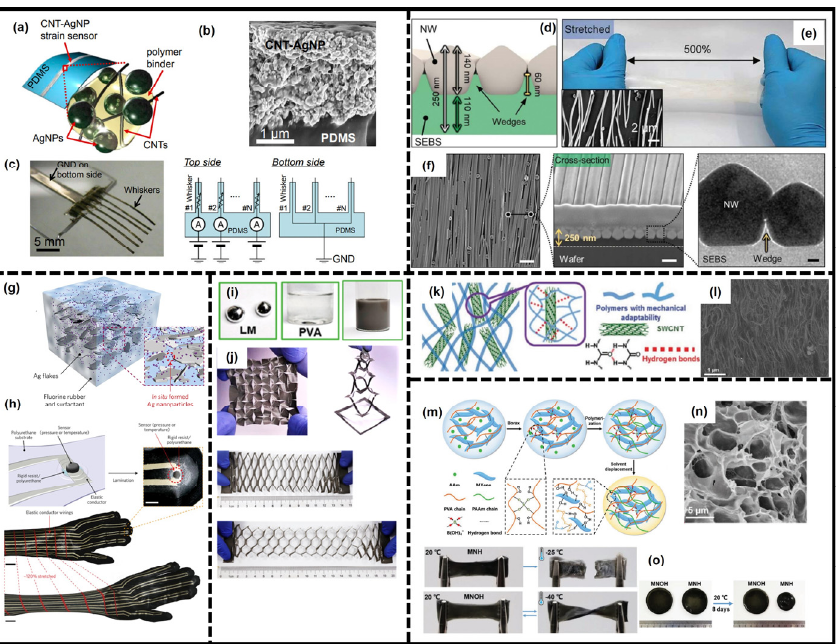
Figure 4. Design strategies of composite materials used in wearable systems. ( a ) Schematic of a CNT-Ag nanoparticle composite film patterned on a PDMS substrate. ( b ) Cross-sectional SEM image of